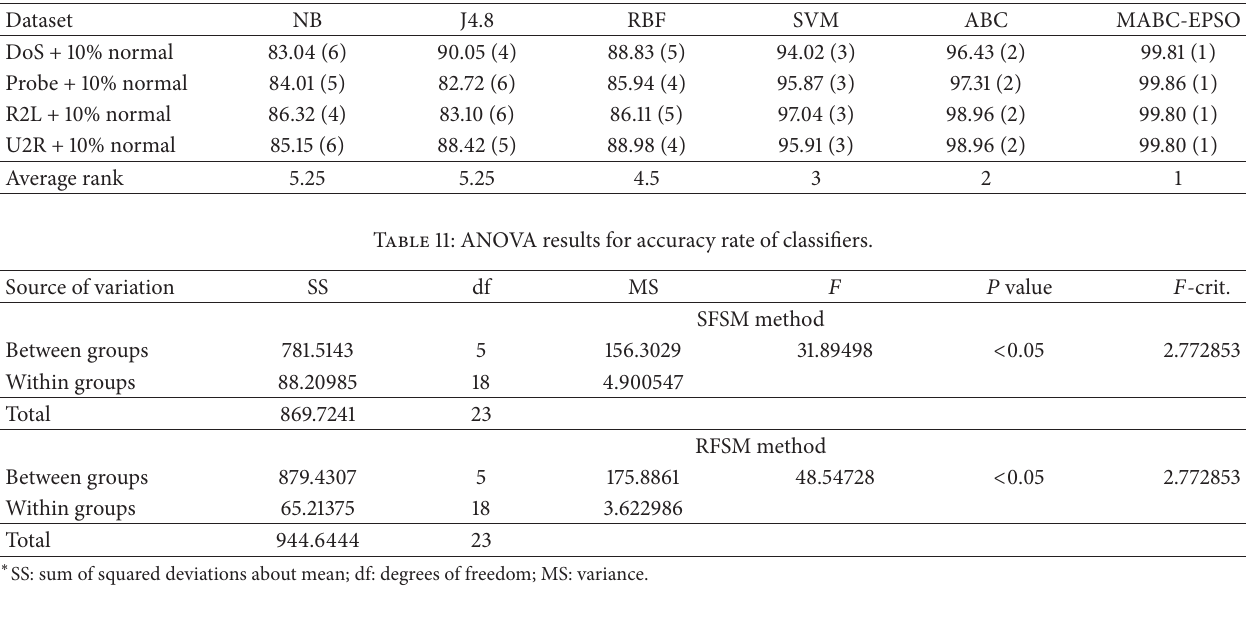
Table 10: Accuracy rates using RFSM feature selection method and Friedman ranks.